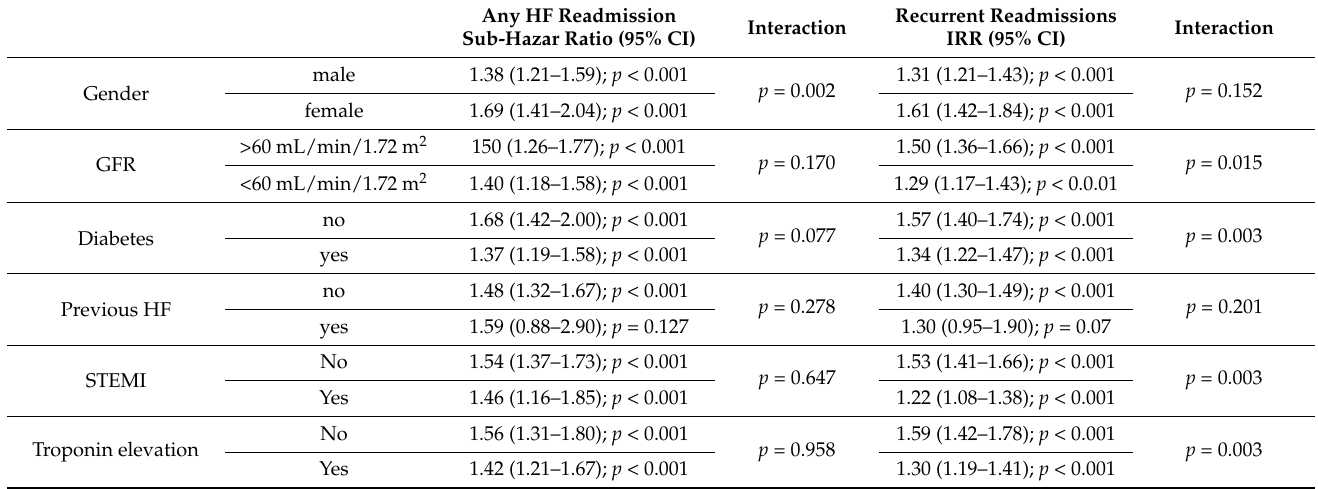
Table 4. Subgroup analysis for the predicted value of pro-BNP heart failure readmission